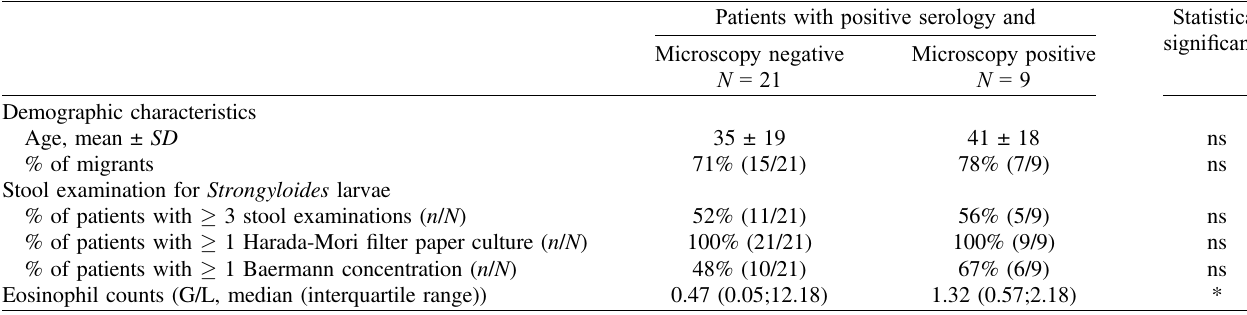
Table 3. Detailed characteristics of patients with a positive serology.